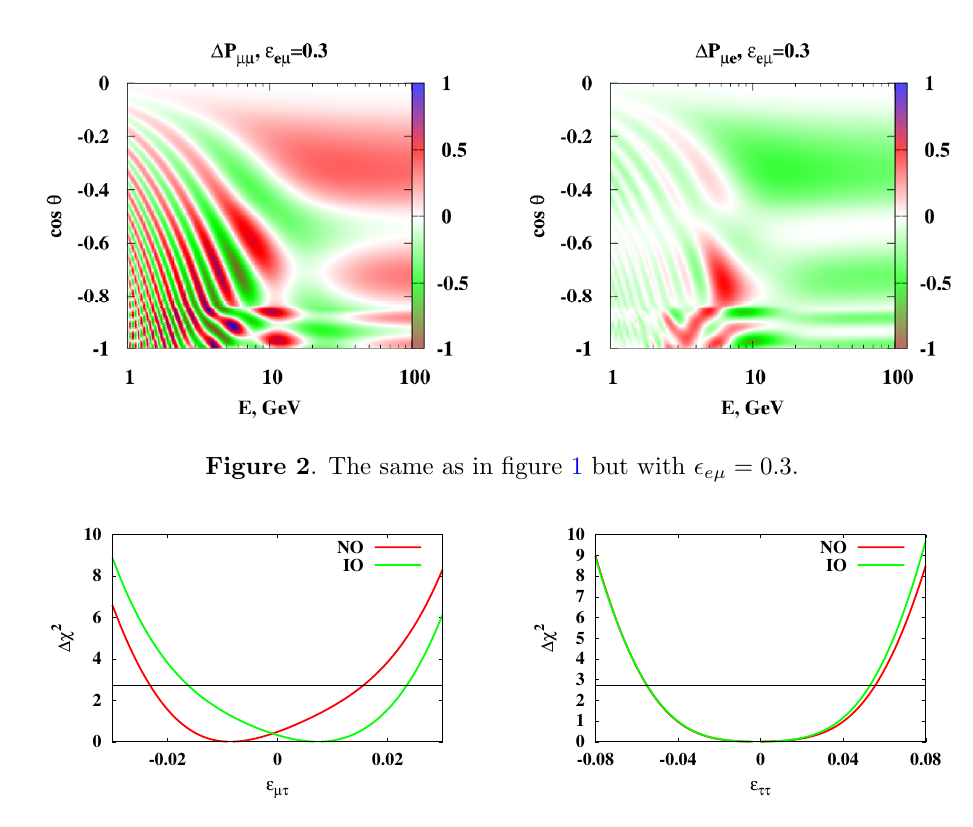
Figure 3 . Values of (cid:1) (cid:31) 2 for the cases of non-zero (cid:15) (cid:22)(cid:28) (left panel) and (cid:15) (cid:28)(cid:28) (right panel). Other matter NSI parameters except for (cid:15) (cid:22)(cid:28) (left panel) and (cid:15) (cid:28)(cid:28) (right panel) are set to zero. Red (dark gray) and green (light gray) lines correspond to normal and inverted neutrino mass hierarchy,